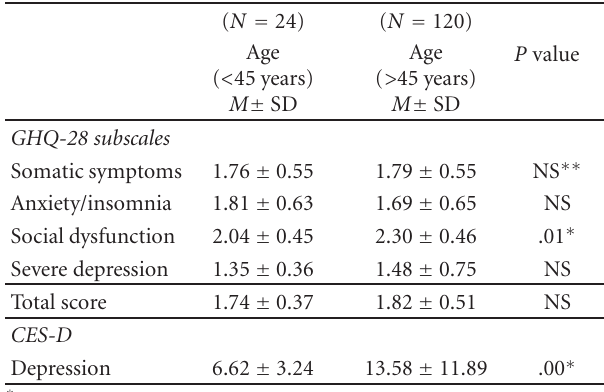
Table 2: Mean scores ± SD of GHQ-28 health subscales, depression and state-trait anxiety. Independent samples t -test demonstrating di ff erences between men and women.